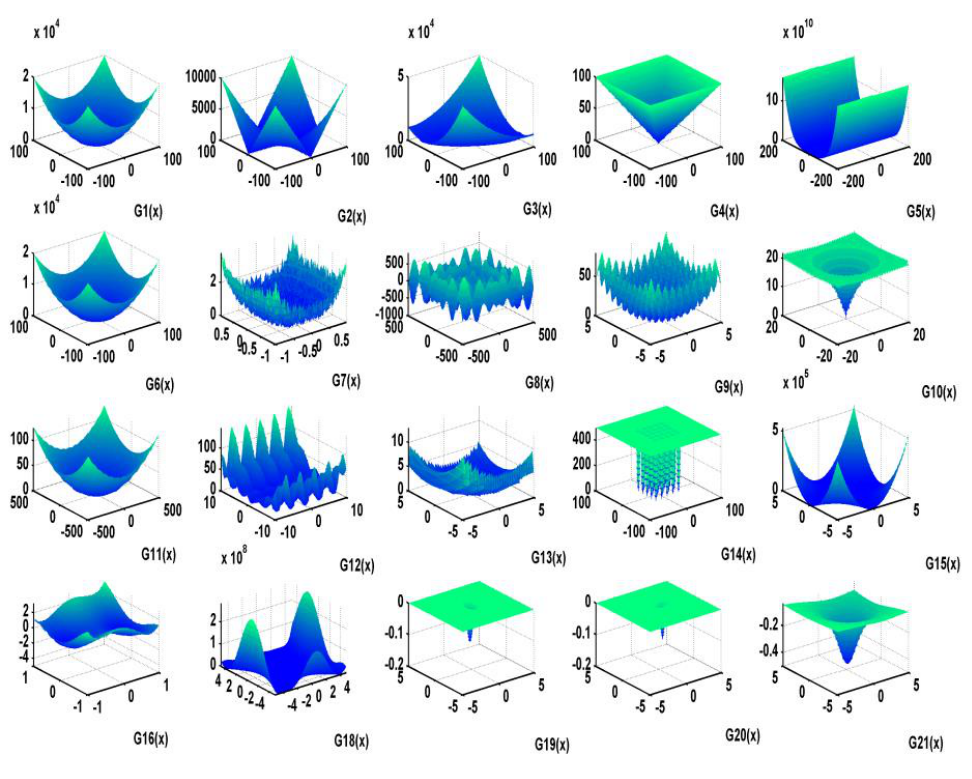
Figure 6. Shape Curve of Benchmark Function